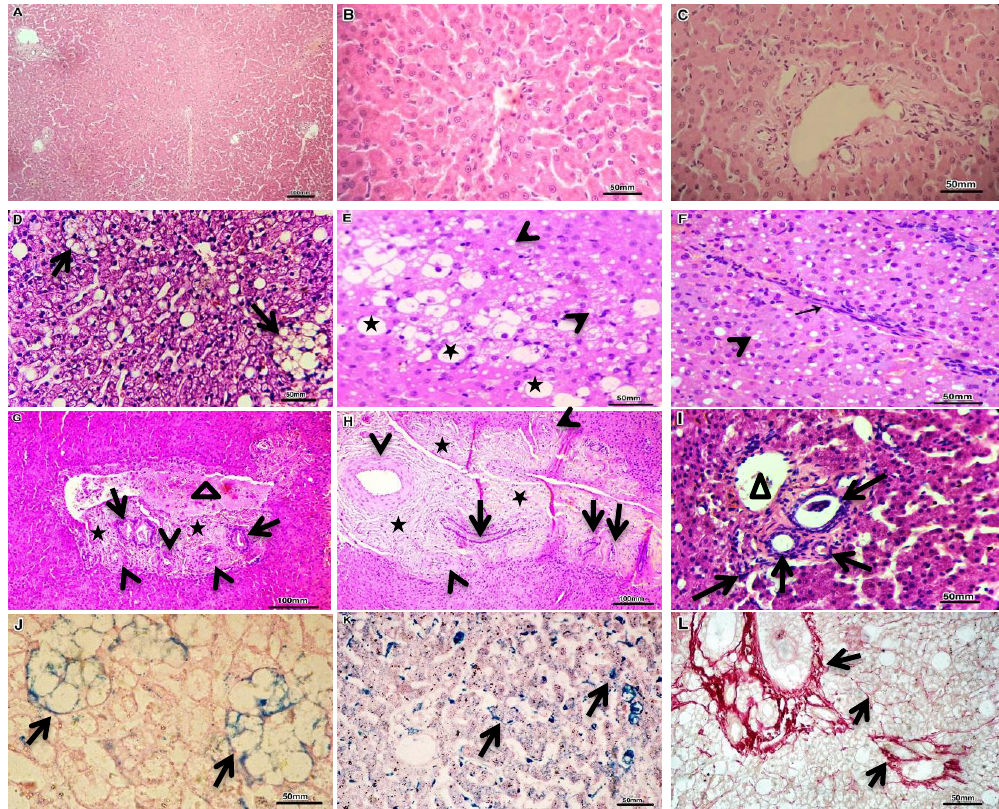
Figure 2. Representative histopathology from dogs affected either with EHPSS or IHPSS, as well as the healthy control ones. H&E stained normal liver sections with normal liver lobules and central vein in its center from which radiate one cell thick liver cell plates towards the portal field, which include hepatic artery, bile duct, and portal vein (A–C) . H&E stained liver sections showed various forms of fatty degeneration, including lipid granuloma ( D , arrows ), macrovesicular steatosis ( E , stars ), and microvesicular steatosis ( E , F , arrowhead ) as well as thick intralobular fibrous septa with lymphocytic infiltration ( F , arrow ). H&E stained liver sections declare the portal area expansion by fibrous tissue deposition ( G , H , stars ), biliary hyperplasia ( G – I , arrows ) and arteriolar proliferation ( G , H , arrowhead ) together with partially occluded portal vein ( G , triangle ), absence of portal vein ( H ) and hypoplastic ( small caliber ) portal vein ( I , triangle ). Perls’ Prussian blue-stained iron salts (hemosiderin’s) within lipid granuloma ( J , arrows ) as well as hepatocytes and sinusoidal Kup ff er cells ( K , arrows ). Picrosirius red-stained fibers of connective tissue (collagen types I and III) in portal and parenchymal areas ( L , arrows